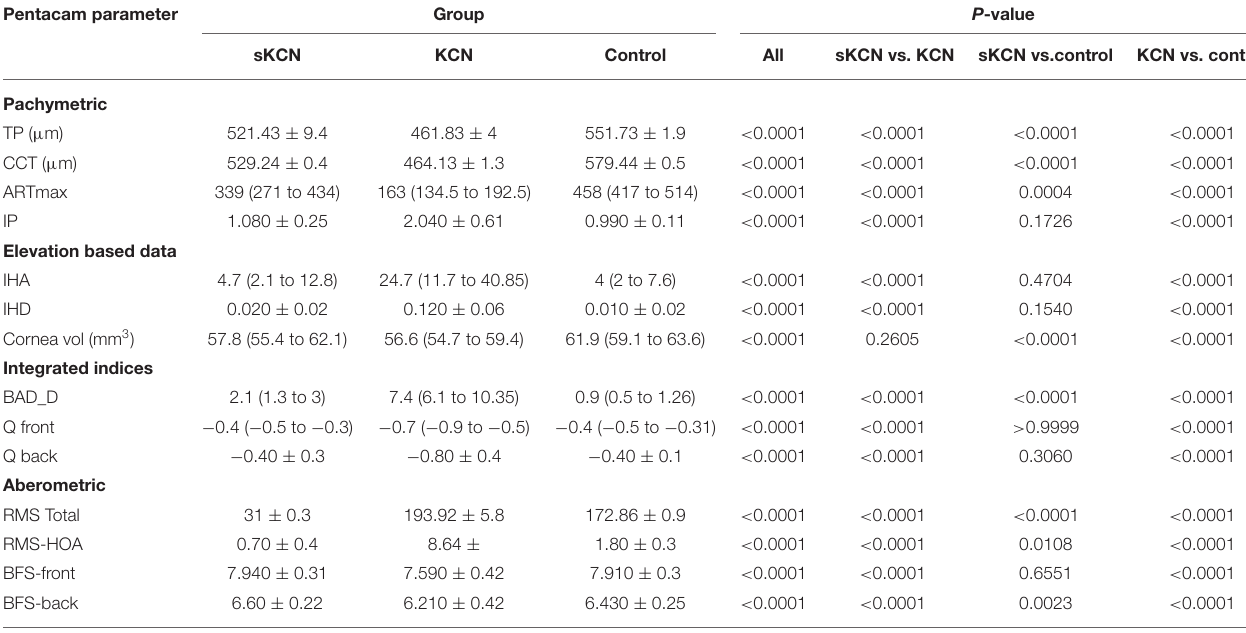
TABLE 4 | Pachymetric parameters, elevation based data, integrated indices and aberometric values by groups: descriptive statistics and comparisons between groups. Pentacam parameter